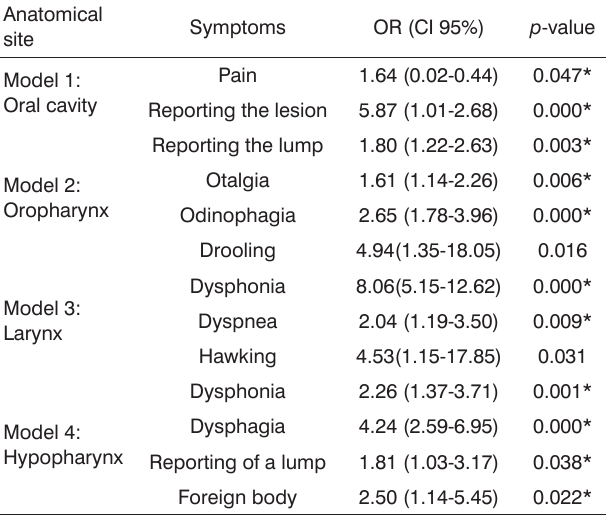
Table 2. The association of UADT SCC patient symptoms variables, according to anatomical site and stage, estimated by the multivariate logistic regression model. Odds Ratio (OR) with a 95% confidence interval